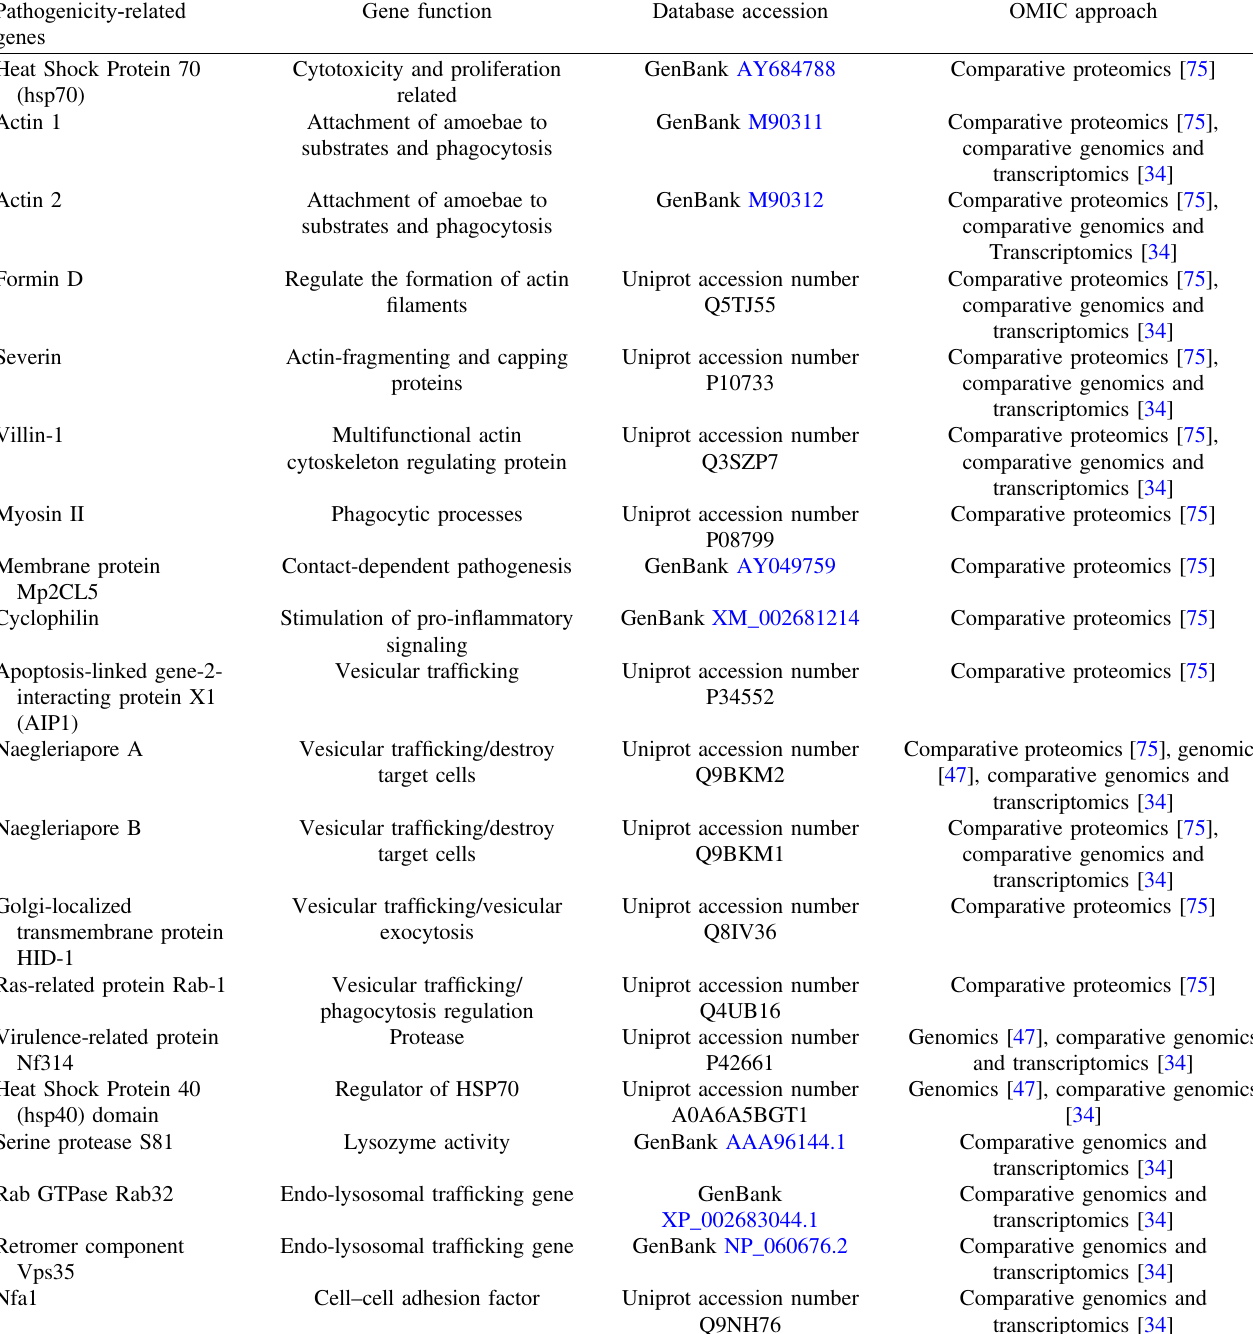
Table 1. Relation of genes described with pathogenicity potential found in N. fowleri